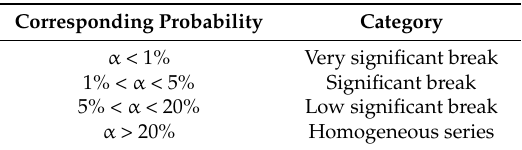
Table 2. Significance level of the Pettitt